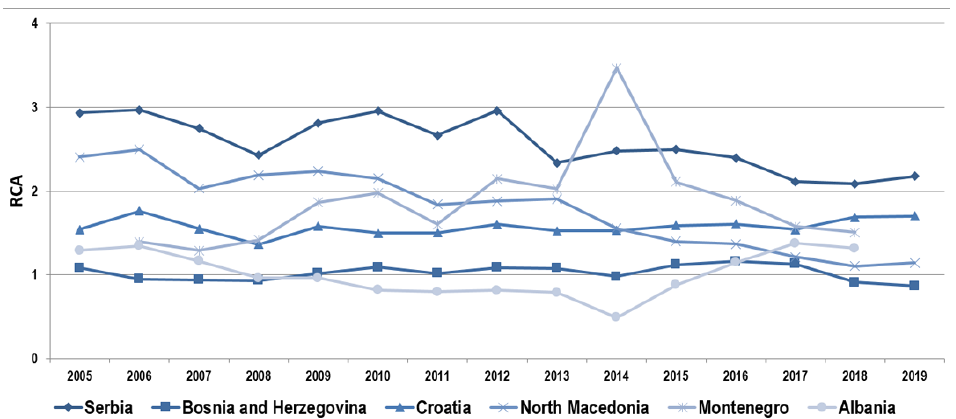
Figure 2. Revealed comparative advantages of the agri-food sector of the WB countries. Source: own research on basis of UN Comtrade [38].